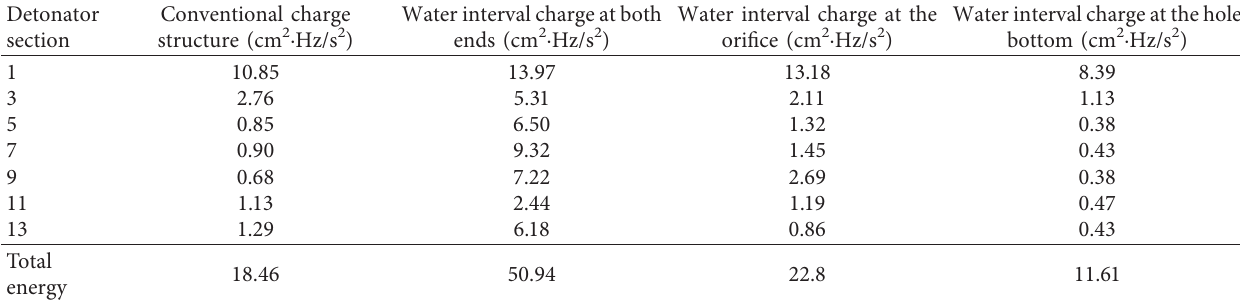
Figure 11: Comparison of instantaneous energy and waveforms. (a) Conventional charge structure. (b) Water interval charge at both ends. (c) Water interval charge at the orifice. (d) Water interval charge at the hole bottom. Table 5: Instantaneous peak energies of the four charge structures.